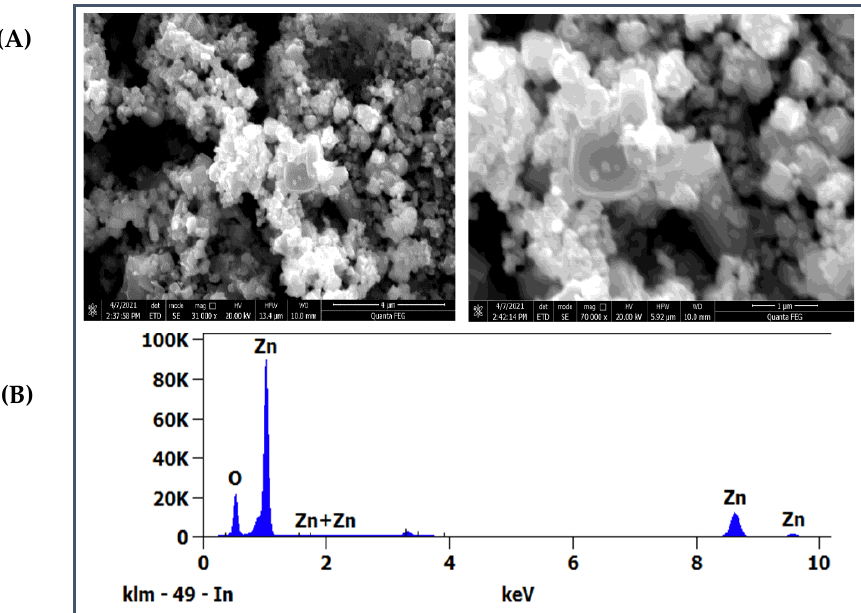
Figure 5. ( A ) SEM micrographs pf the biosynthesized ZnO nanoparticles; ( B ) EDX spectrum. The morphology and the size of ZnO NPs prepared by green synthesis were elucidated by TEM analysis. Figure 6 illustrates that the particles were highly dispersed and with different shapes: platelets, bricks, cylinders, and blades. As it can be seen in the TEM images, the size of the nanoparticles ranged from 28 to 270 nm, depending on the shape of the particle. The size of the particles was calculated using ImageJ software [50].